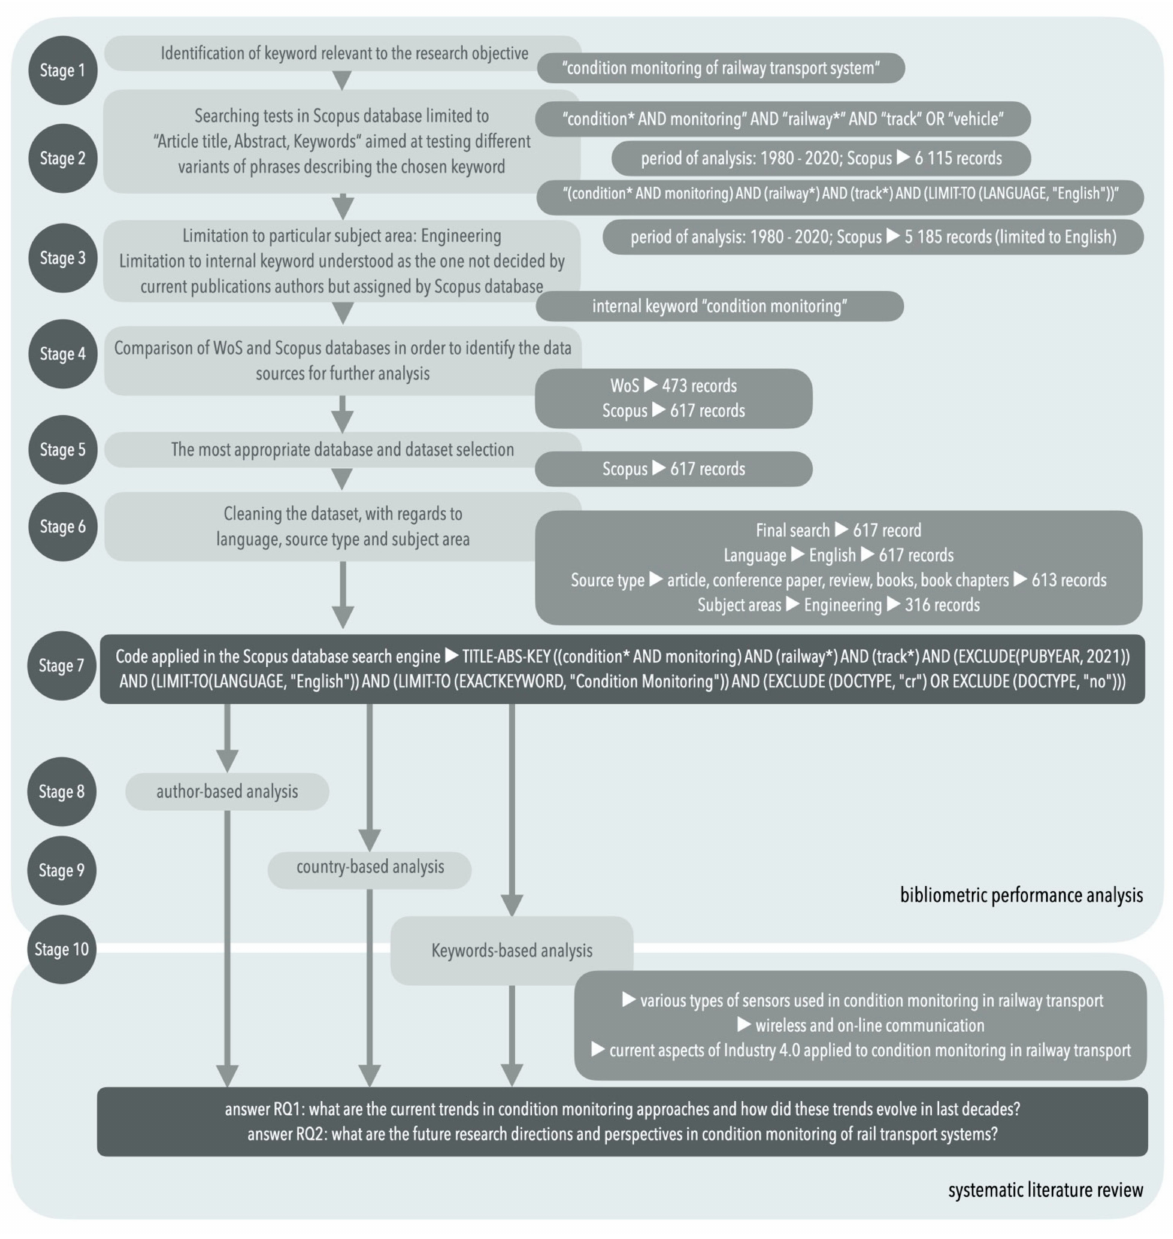
Figure 1. The procedure of the conducted research review. Source: based on [58] (p. 89),